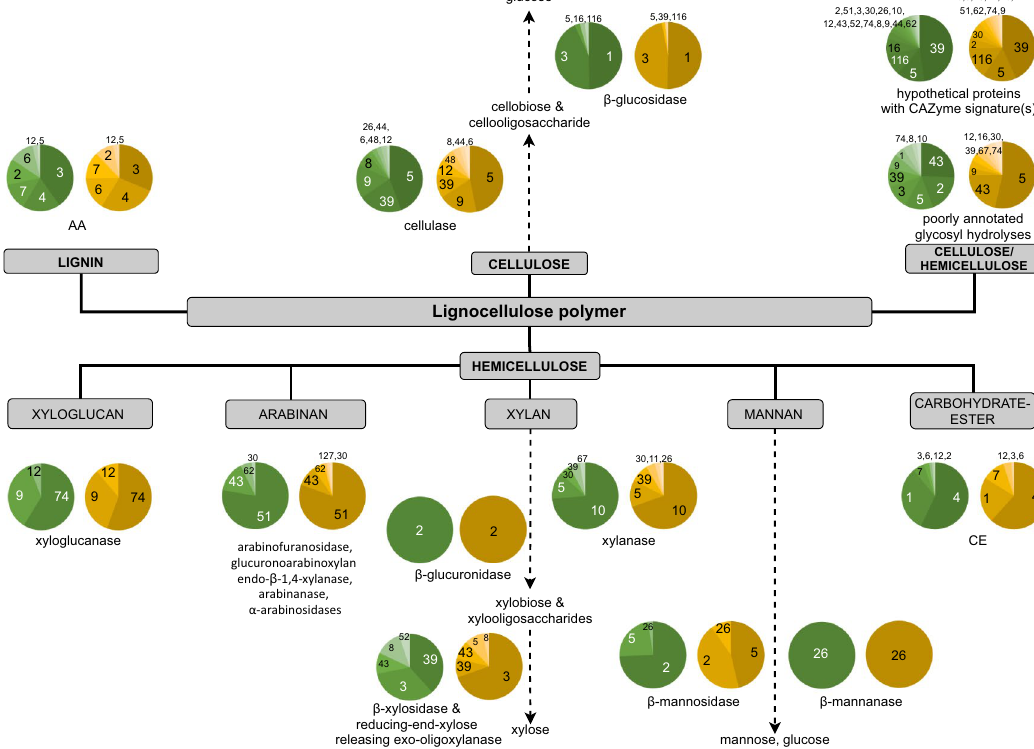
Figure 4. Putative lignocellulosic degradation pathway. Chart with green and beige shades refer to green- and brown mat, respectively. Numbers in each pie chart refer to families of AA, CE, or GH (i.e., GH5 and GH10 is indicated by 5 and 10,